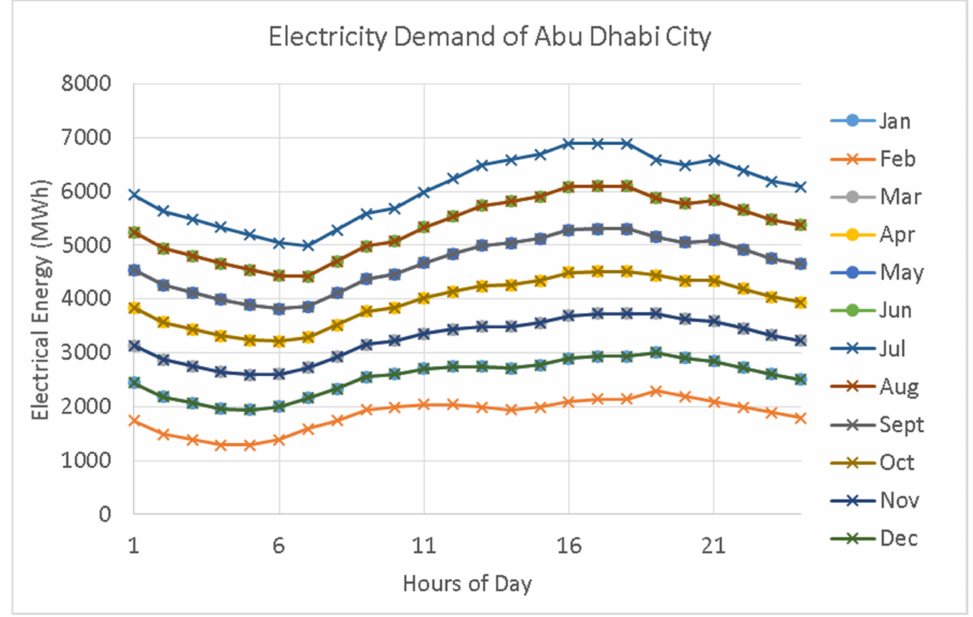
Figure 7. Hourly electricity demand of Abu Dhabi city for each month